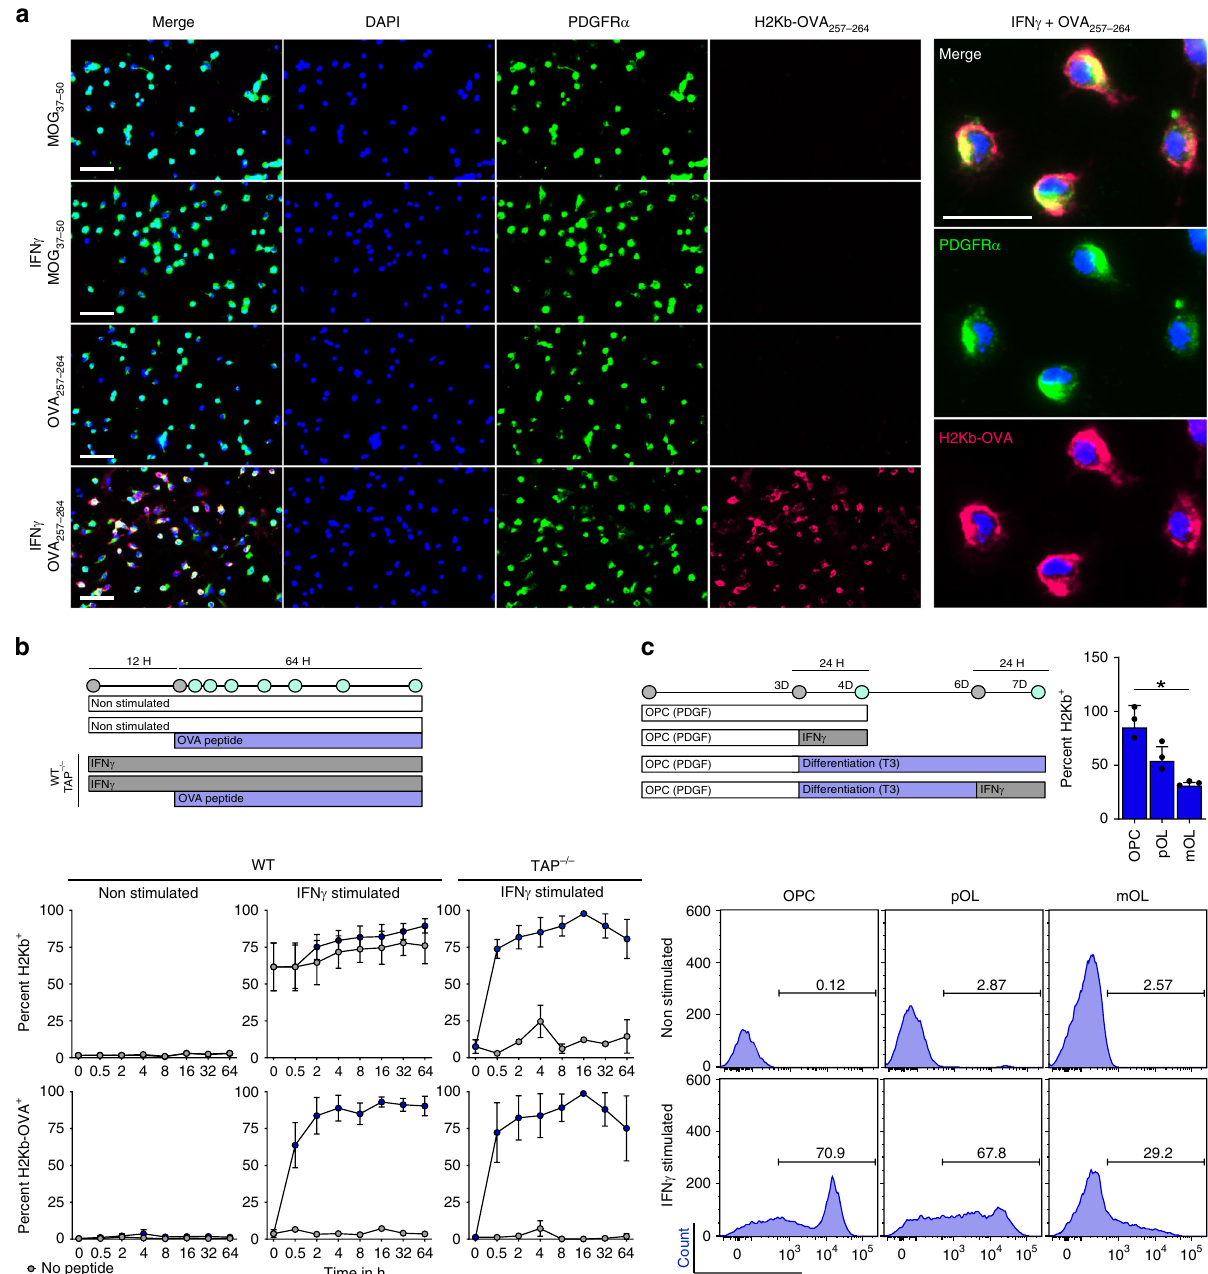
Fig. 4 IFN γ induces peptide processing and presentation in OPCs. a Immunocytochemical staining of primary C57BL/6 mouse OPCs which were cultured under PDGF conditions (20 ng/mL) or with IFN γ (10 ng/mL) for 12 h prior to addition of the MHC class I restricted MOG 37 – 50 peptide (50 μ g/mL) or OVA 257 – 264 peptide (50 μ g/mL) (scale bar = 50 μ m). MCH class I restricted ovalbumin peptide presentation on OPCs was determined using PDGFR α and H2Kb-OVA 257 – 264 antibodies. The right panel shows high magni fi cation (25 μ m) of IFN γ + OVA 257-264 culture. b Time course experiments of WT and TAP − / − OPCs cultured with/without IFN γ and with/without OVA γ was completed for 12 h prior to the addition of no peptide 257 – 264 peptide. Treatment of IFN (gray) or OVA 257 – 264 peptide (blue) ( c ). MHC class I expression was determined from three stages of oligodendrocyte lineage cells either unstimulated or stimulated with IFN γ for 24 h. Oligodendrocyte lineage populations were de fi ned by PDGFR α , A2B5, and O4 markers under proliferative or differentiating conditions (OPC vs. pOL mean diff = 30.9, 95% CI = − 13.6 – 75.5, OPC vs. mOL mean diff = 54.1, 95% CI = 5.2 – indicating that oligodendrocyte lineage cells within human white PSMB8 + in the WML regions compared to NAWM and healthy matter MS lesions upregulate a key component of the immuno- control brain white matter (Fig. 10b). To ascertain which cells proteosome pathway. Taken together, the results show that oli- within the lesion were expressing PSMB8, parallel sections were godendrocyte lineage cells in MS WML upregulate the co-immunostained with the oligodendrocyte lineage marker Sox- immunoproteosome pathway speci fi cally in areas of failed 10 (Fig. 10c). There were signi fi cantly more PSMB8 + /Sox-10 + cells in WML compared to control and NAWM (Fig. 10d), remyelination.